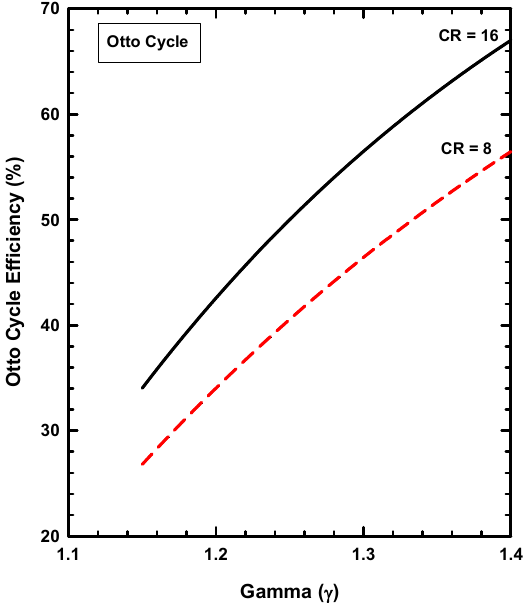
Figure 24. The thermal efficiency for the Otto cycle as a function of gamma for compression ratios of 8 and 16.